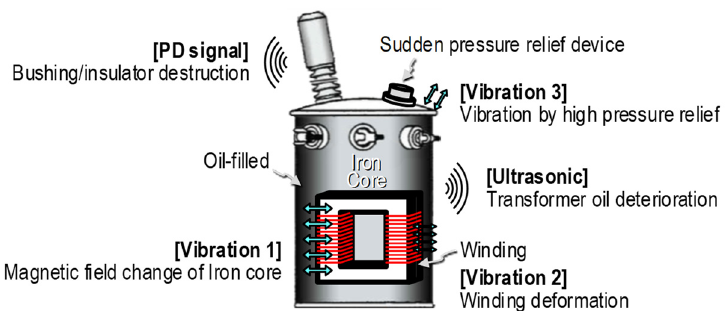
Figure 1. Various faults and their physical properties in a power transformer.